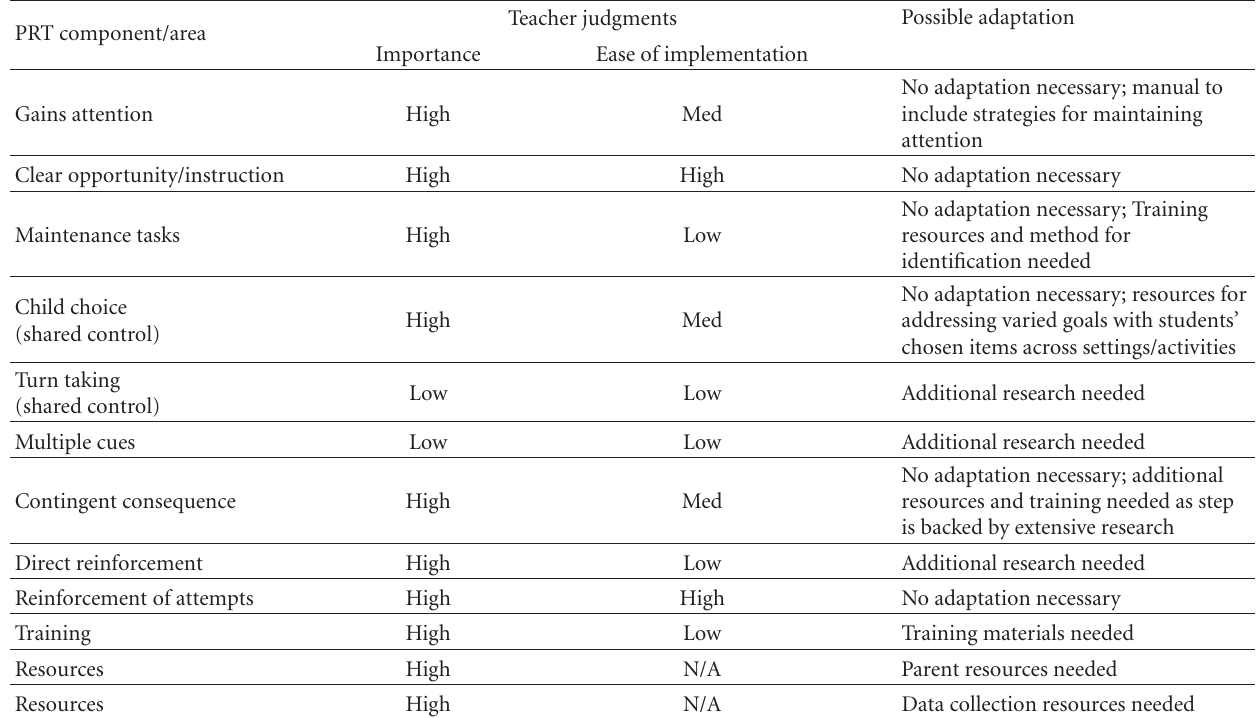
Table 2: Summary of recommended adaptations based on teachers’ perspectives and quality of classroom